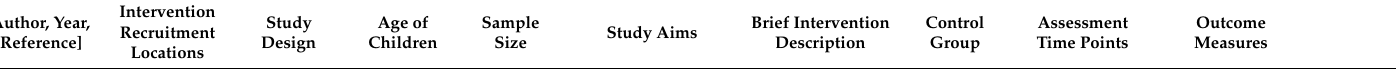
Table 1. Overview of included